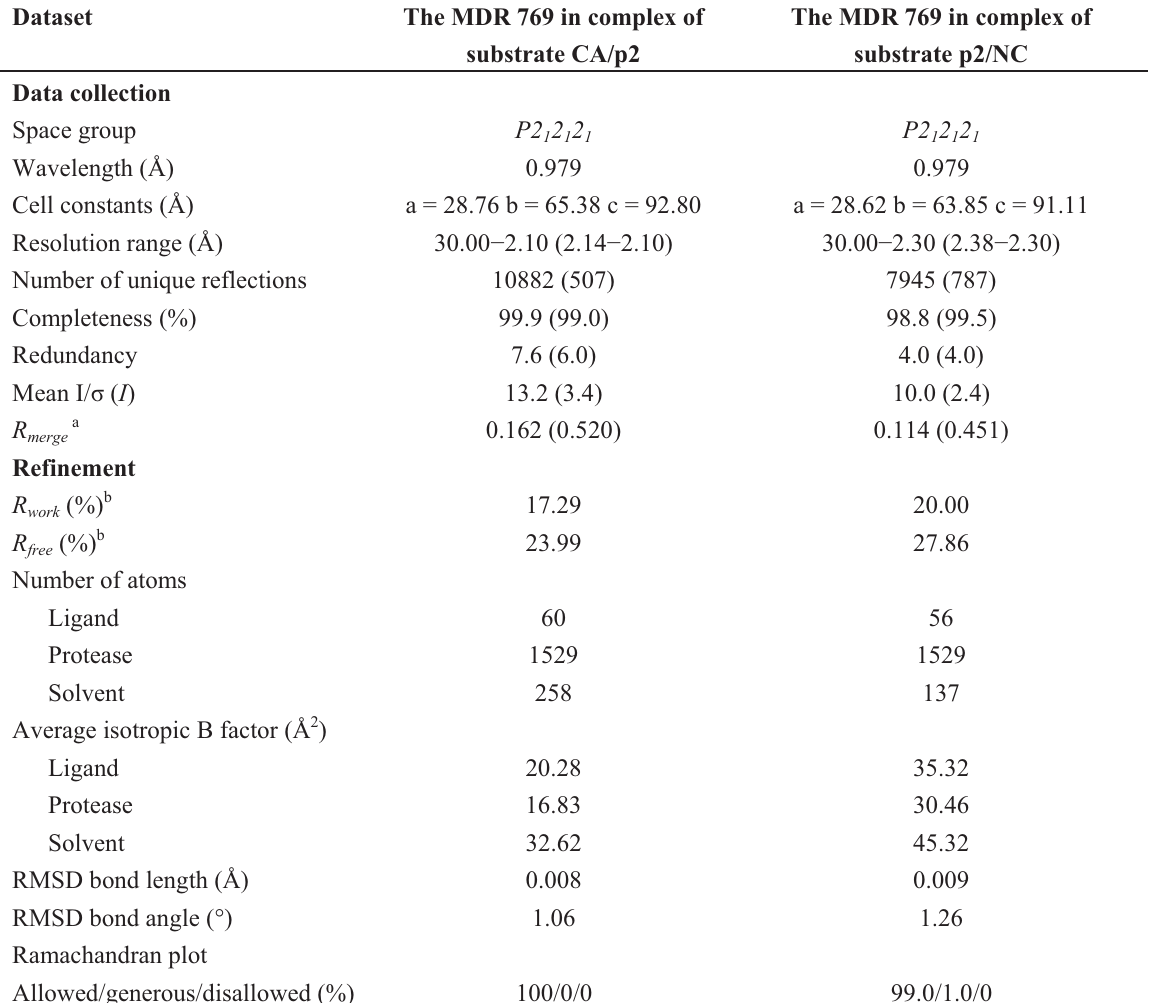
Table 2. Crystallographic